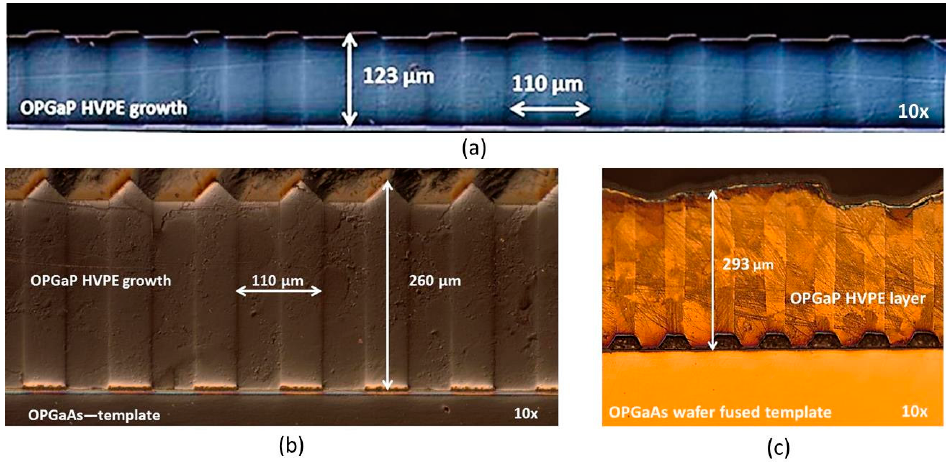
Figure 30. Typical cross sections images of OPGaP grown by HVPE on Molecular Beam Epitaxy (MBE) assisted polarity inversion OPGaAs templates after: ( a ) 2–3 h of growth, and ( b ) 6–8 h of growth; ( c ) OPGaP grown by HVPE on wafer bonded OPGaAs templates [59]. (Reproduced from [59] with the permission of OSA).